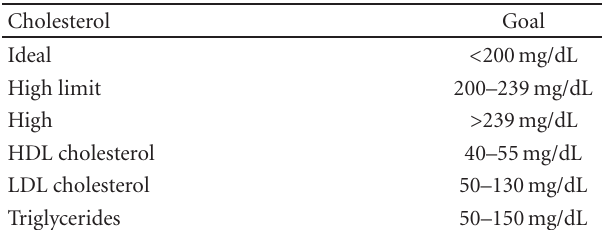
Table 1: Levels of total cholesterol, triglycerides, HDL cholesterol, and LDL cholesterol according to NECP Guidelines. Adult Panel III